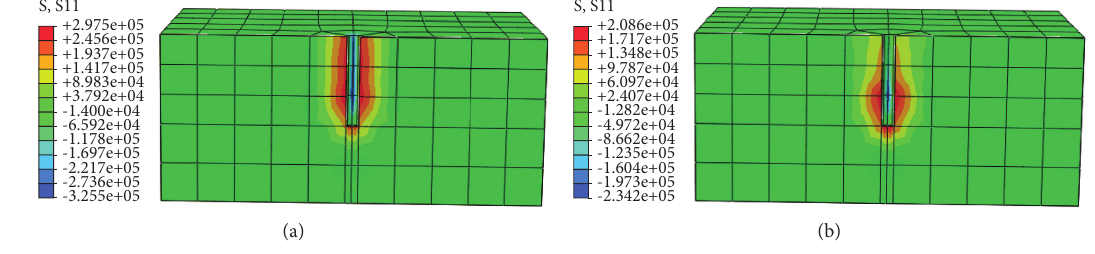
Figure 12: Bond stress (unit: MPa). (a) Before. (b) After.